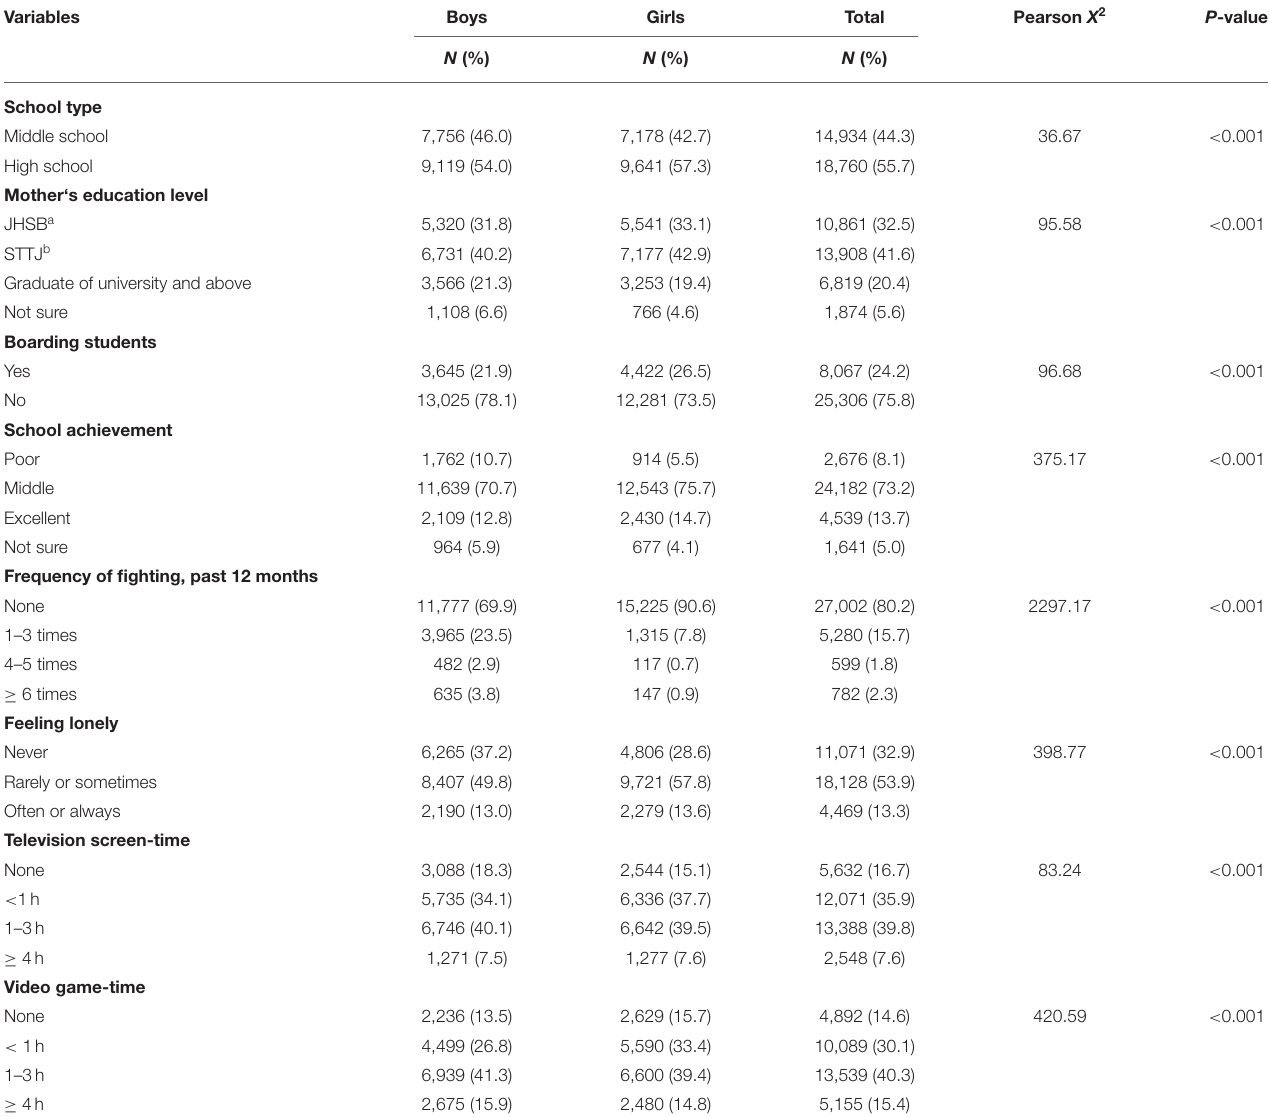
TABLE 1 | Characteristics of sociodemographic variables overall and by gender, N = 33,694.